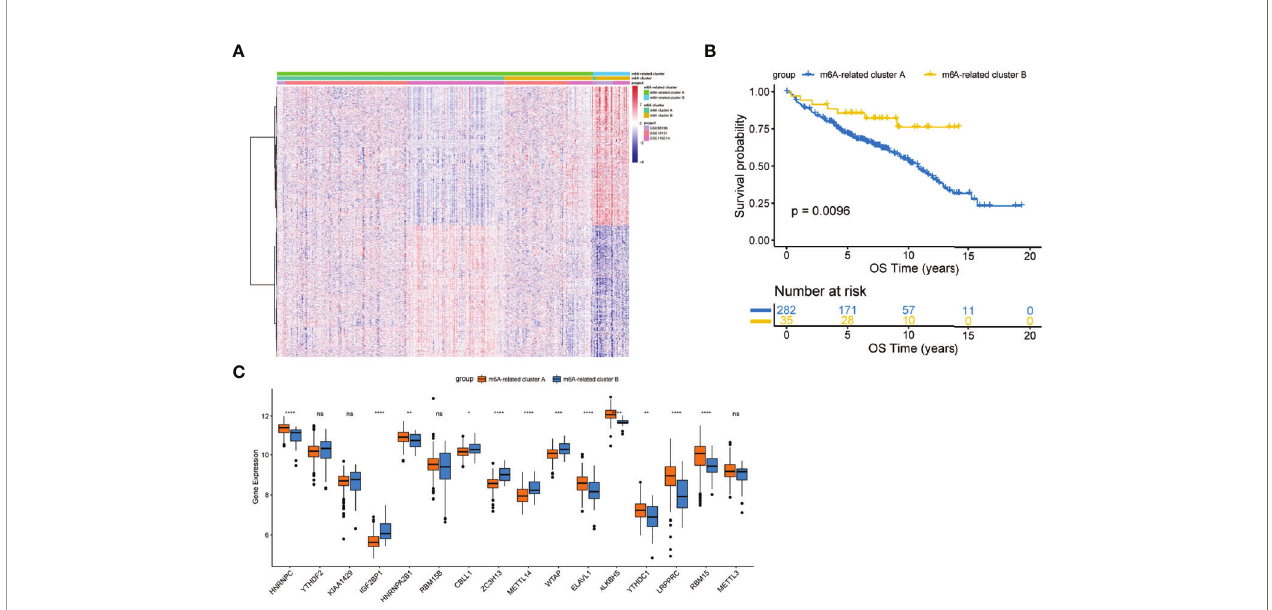
FIGURE 2 | Construction of the m6A-related clusters. (A) Patients were classi fi ed into m6A-related cluster A and B groups by unsupervised clustering based on the differentially expressed genes between m6A clusters. (B) Survival differences according to m6A-related clusters by the log-rank test. (C) Differential expression of 16 m6A-regulators between the m6A-related cluster A and B groups. NS, not signi fi cant; *p < 0.05; **p <0.01; ***p < 0.001; ****p <